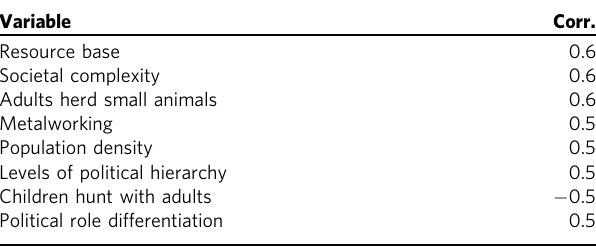
Table 2 Correlation between SCCS variables and the estimated gift degree